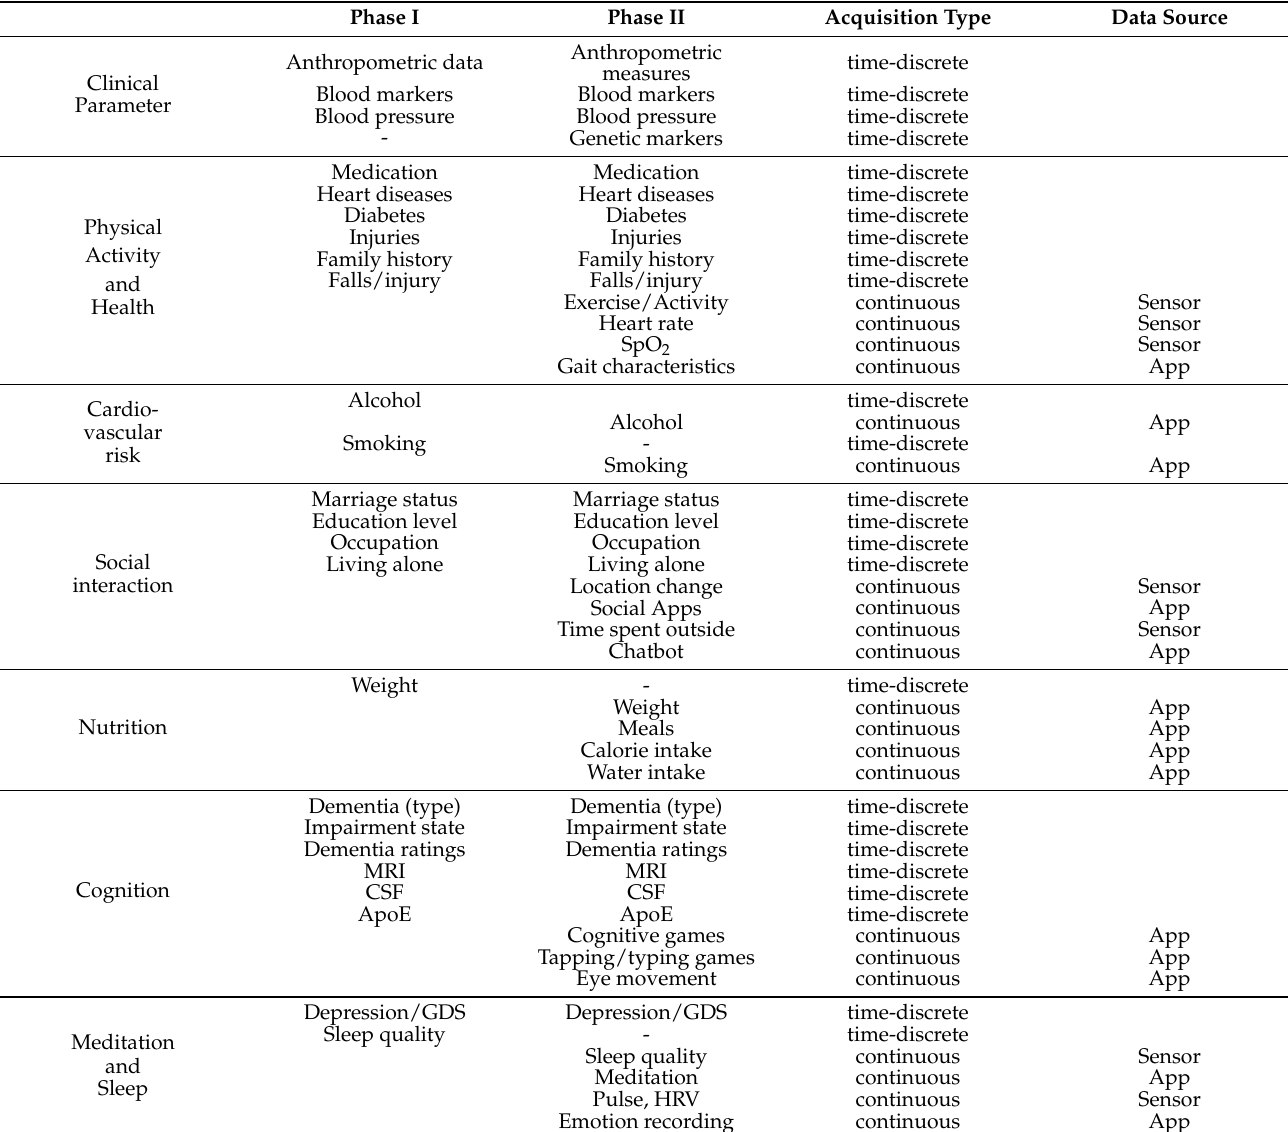
Table 1. Available data for phases I and II of the LETHE